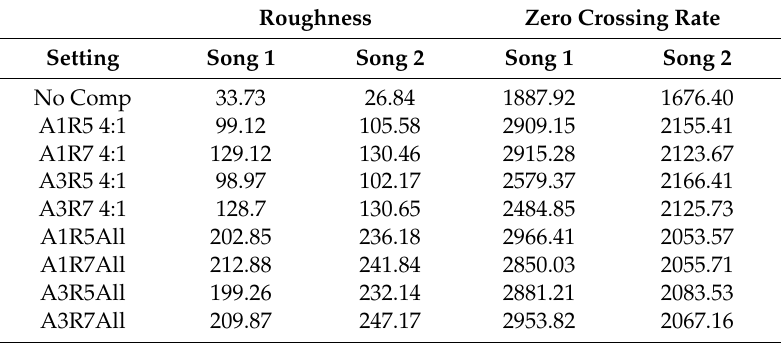
Table 5. Roughness and zero crossing rate (ZCR) features extracted from the vocal material used in test